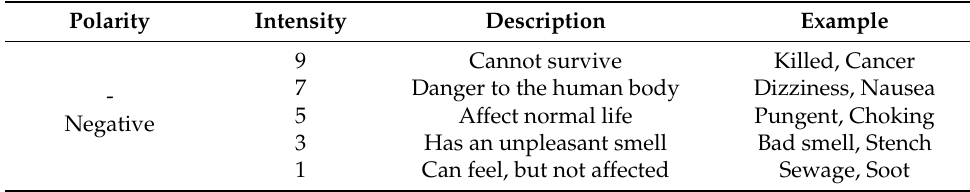
Table 2. Emotion intensity labeling criteria.